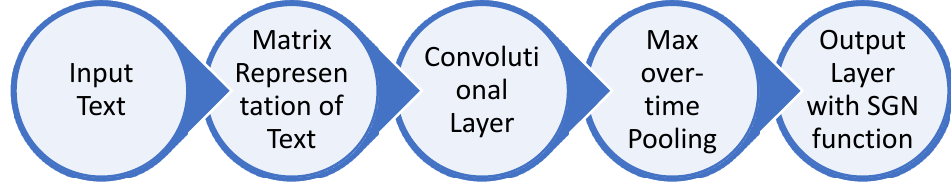
Figure 4. The architecture of the CNN algorithm with two channels for sentence classification .